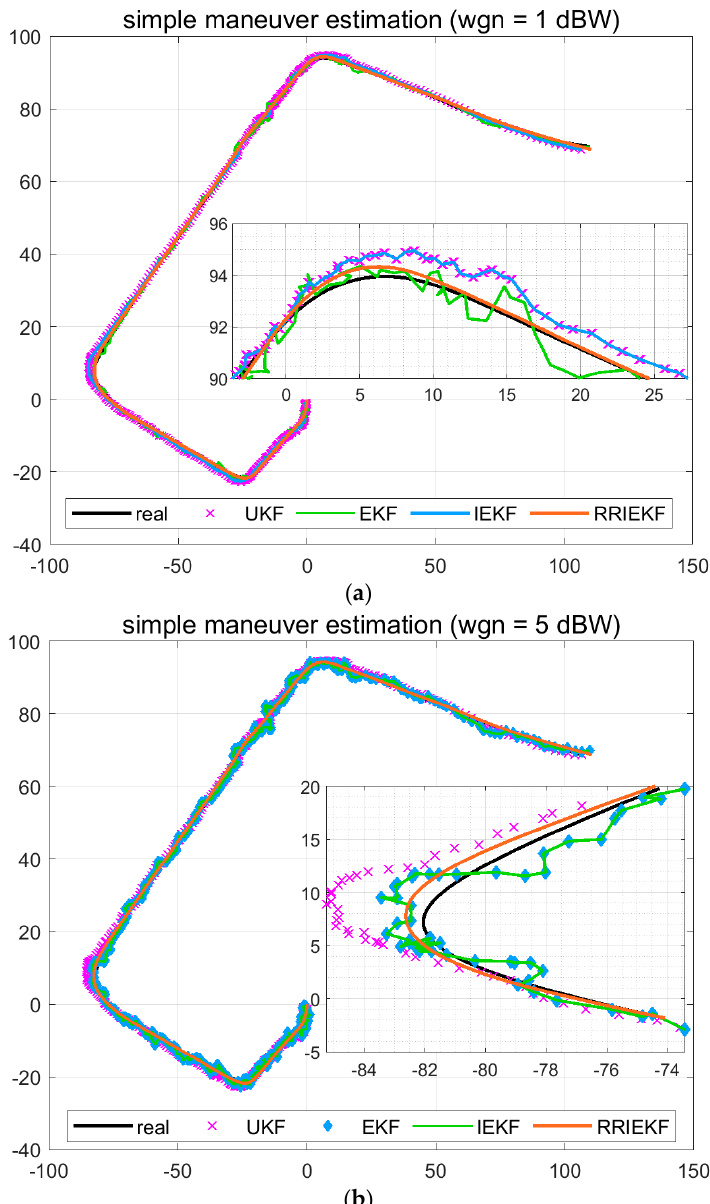
Figure 2. ( a ) Simple accelerative and turning movement estimation at 1 dBW WGN. ( b ) Simple accelerative and turning movement estimation at 5 dBW WGN.